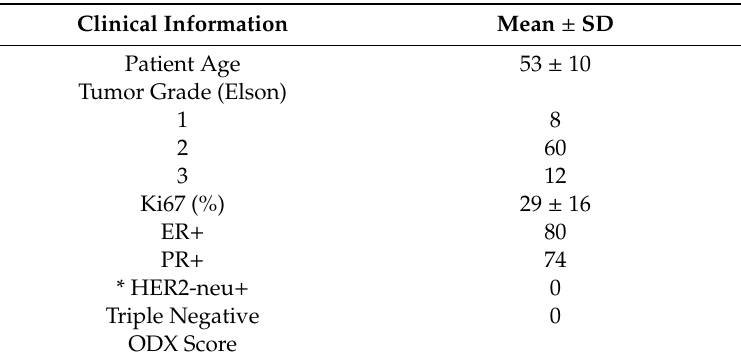
Table 1. Patient clinical parameters and